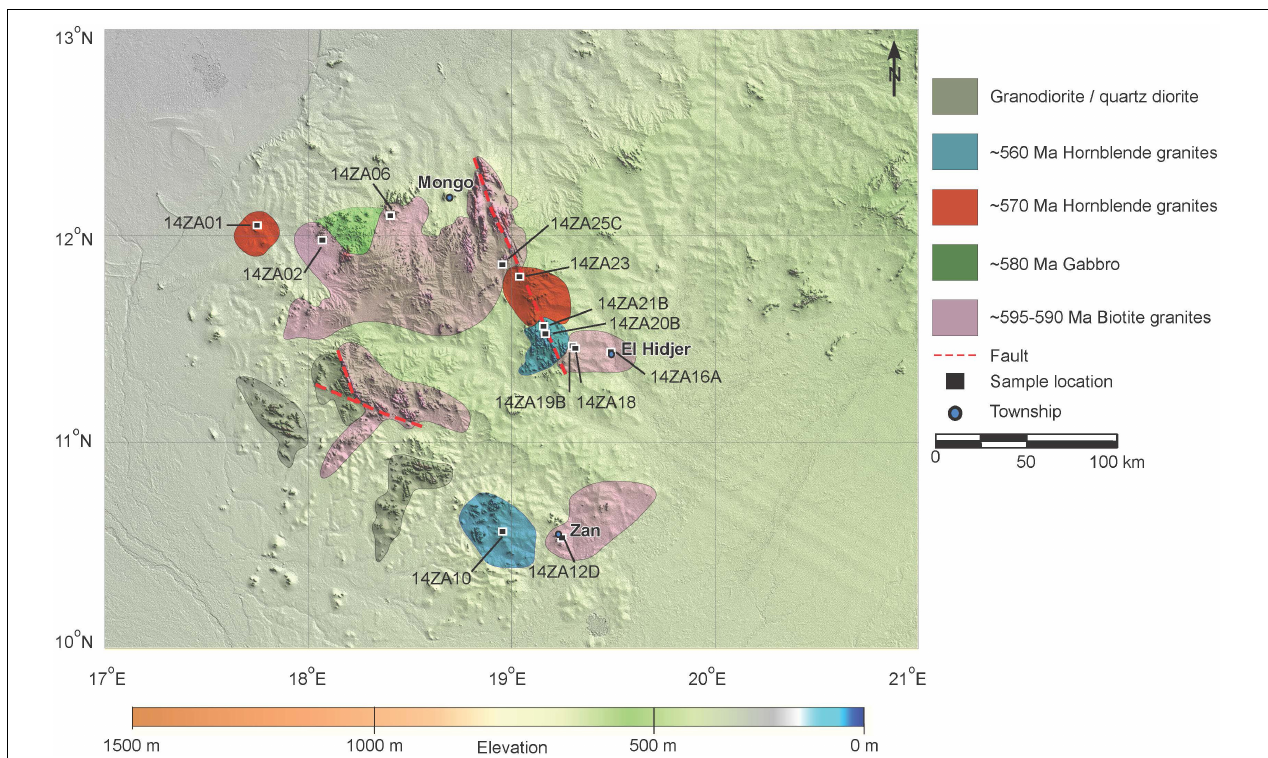
FIGURE 2 | Sample location map of the granitoids selected for this study. The distribution of Guéra Massif granites draped onto Shuttle Rader Topography Mission (SRTM) Digital Elevation Model